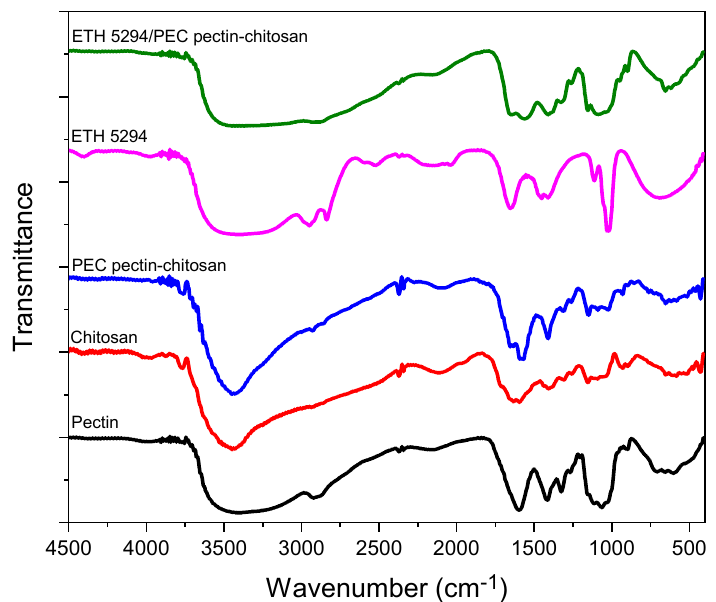
Figure 2. FT-IR profiles of pectin, chitosan, PEC pectin–chitosan, ETH 5294 and ETH 5294/PEC pectin–chitosan.